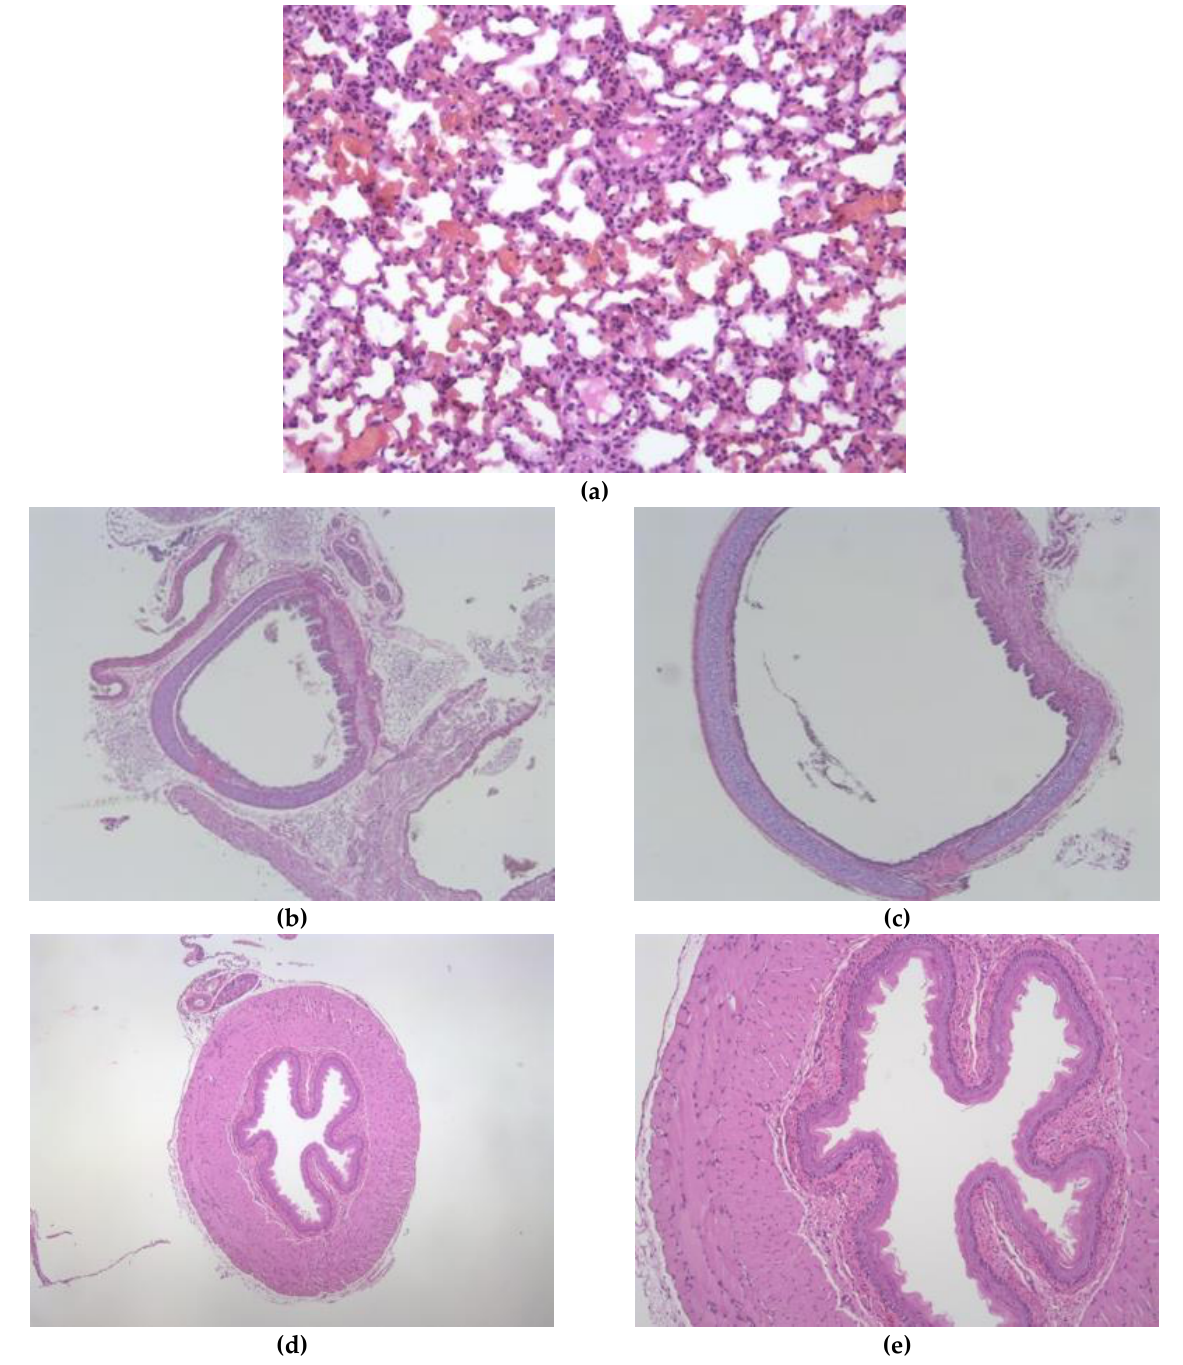
Figure 6. Upper respiratory tracts fixed in 10% formalin, dehydrated, paraffin embedded, sectioned in slices with 4 μm thickness and stained with H&E: ( a ) Lung (200×) with description of absence damage; ( b,c ) Trachea (10×, 40×) with description of absence damage; and ( d,e ) Esophagus (40×, 100×) with description of absence damage.